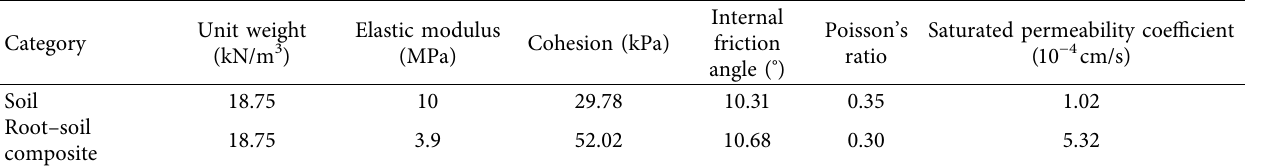
Figure 4: Root content change curve with depth (each point in the figure is test data, and the curve is an average value). Table 3: Physical and mechanical parameters of soil